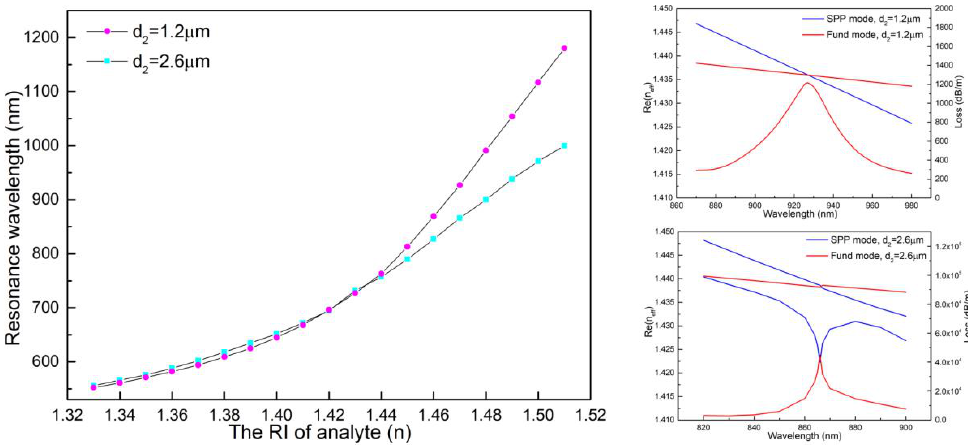
Figure 7. ( Left ): Resonance wavelength with variation in n . ( Right ): Dispersion relationship of the fundamental mode and the SPP mode at d 2 = 1.2 μm and d 2 = 2.6 μm with n = 1.47.